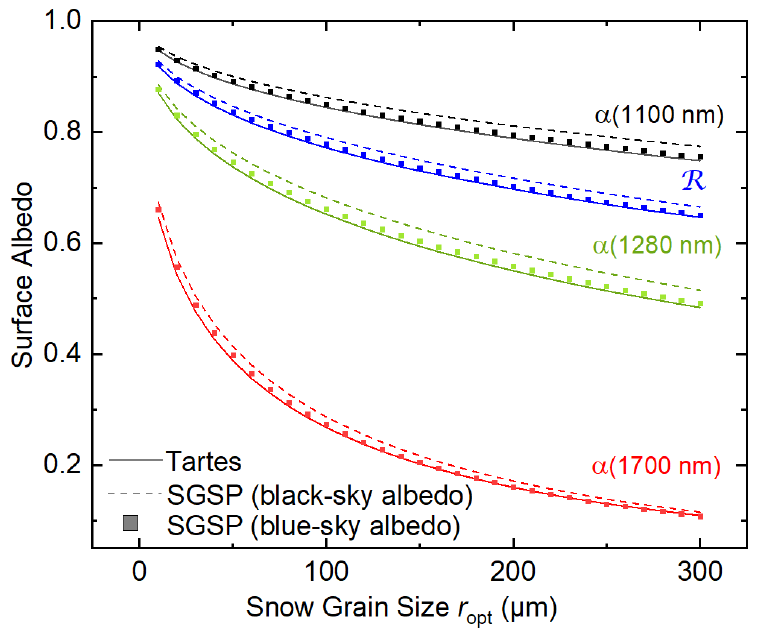
Figure 3. Simulated surface albedo of different snow grain sizes r opt for 1100, 1280, and 1700 nm wavelength using TARTES (solid lines) and the SGSP equations for black-sky and blue-sky-albedo (dashed lines, filled squares) for SZA=80°. Additionally, the albedo ratio R is plotted for all